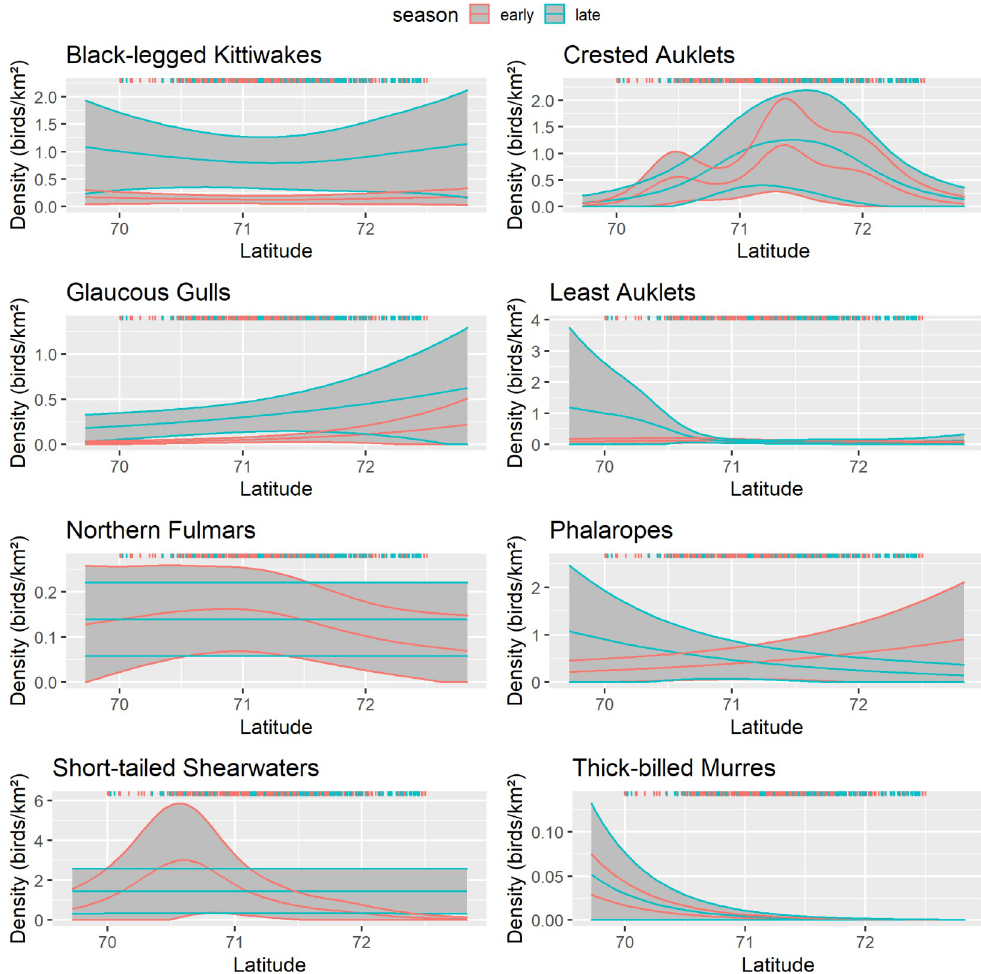
Fig 12. Effect of latitude on seabird density, northeastern Chukchi Sea, 2008–2018. Response curves are from the best- fitting generalized additive model. Solid lines represent the smooth function and 95% confidence limits for early summer (pink) and late summer(aqua). Gray shading indicates the 95% confidence intervals. Colored ticks indicate the distribution of